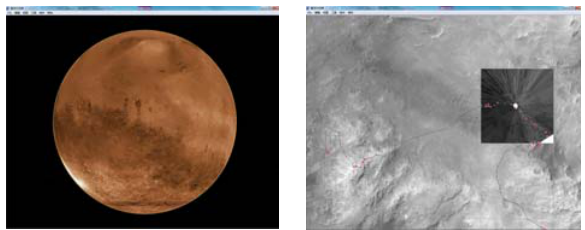
Figure 9. Globe viewer